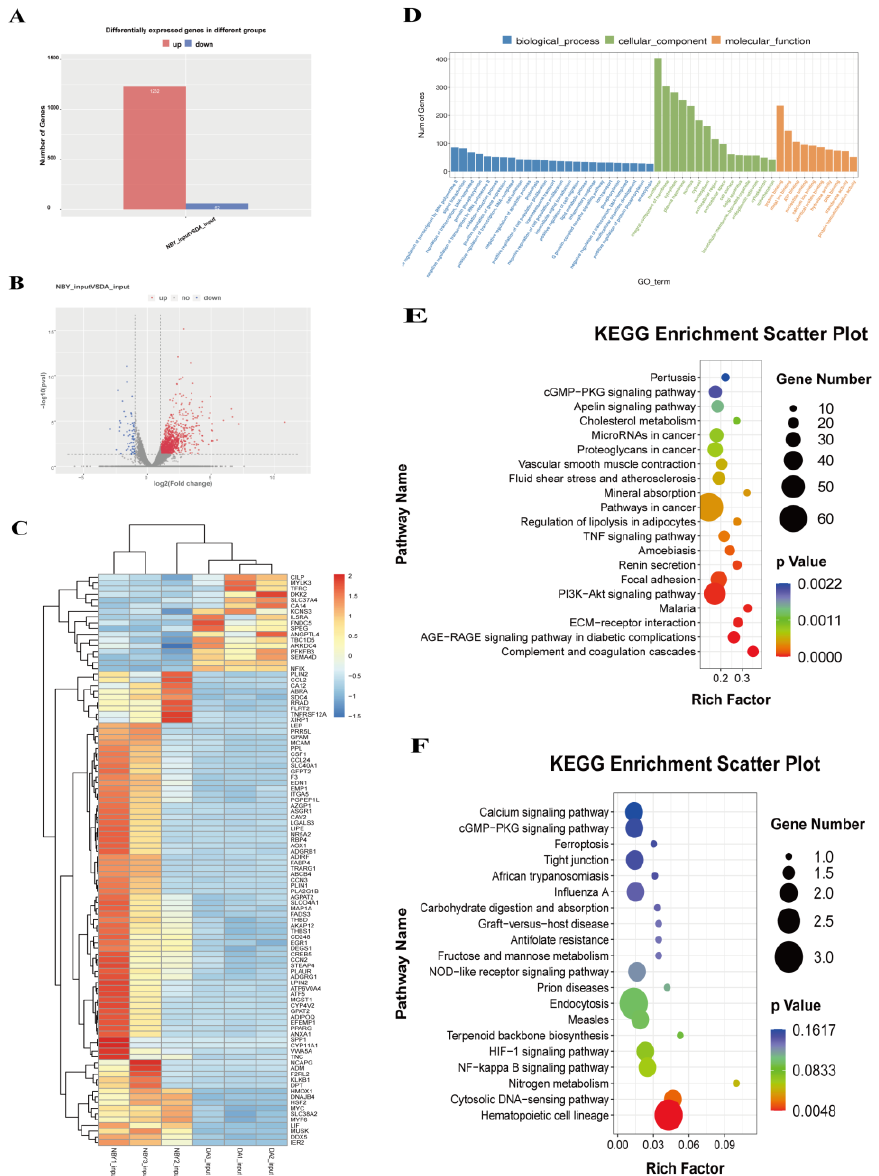
Figure 5. Analysis of differentially expressed genes (DEGs) between NBY and DA. ( A ) Number of up-regulated and down-regulated DEGs. The red column indicates up-regulated DEGs and the blue column indicates down-regulated DEGs. ( B ) The volcano of DEGs. ( C ) Heat map of DEGs. ( D ) GO analysis for DEGs. ( E ) KEGG pathway analysis of up-regulated DEGs. ( F ) KEGG pathway analysis of down-regulated